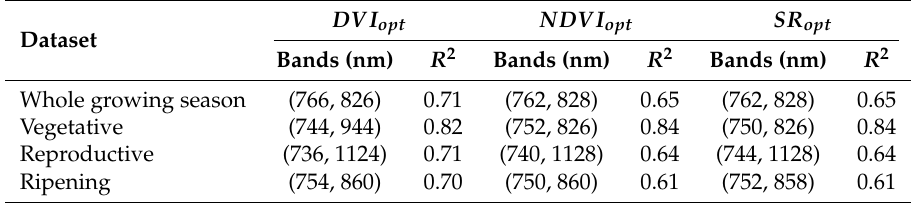
Figure 3. Calibration R 2 counterplot for linear regression models built on difference vegetative index (DVI), normalized difference vegetation index (NDVI) and simple ratio vegetation index (SR) (Table 2) with all possible two band pair combinations against LAI. Table 4. Band combinations that yielded the highest R 2 to predict paddy rice leaf area index (LAI) of the difference vegetative index (DVI), normalized difference vegetation index (NDVI) and simple ratio vegetation index (SR) for whole growing season and each single growth